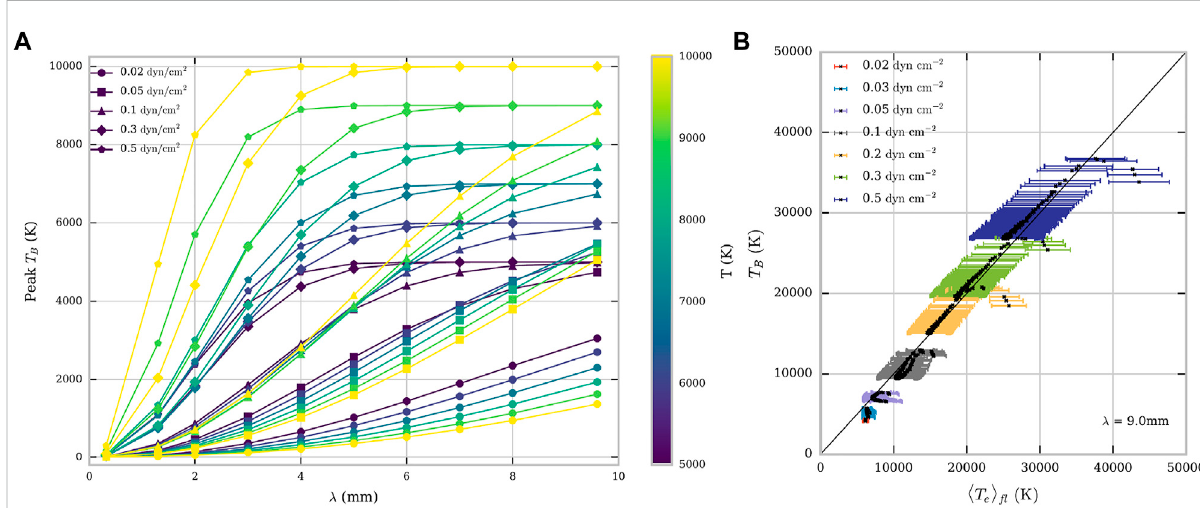
FIGURE 3 (A) : Brightness temperature as a function of wavelength for isothermal isobaric prominence models. Colours correspond to plasma temperature (see colour bar on the right) and different symbols indicate different pressures. The grey-shaded areas show ALMA Bands 3 and 6. (B) : Brightness temperature as a function of plasma temperature averaged over the formation layer of the 9 mm radiation. The error bars show the standard error in the mean for the average plasma temperature. Colours correspond to different pressures, as indicated in the legend. Adapted from Rodger and Labrosse (2017).